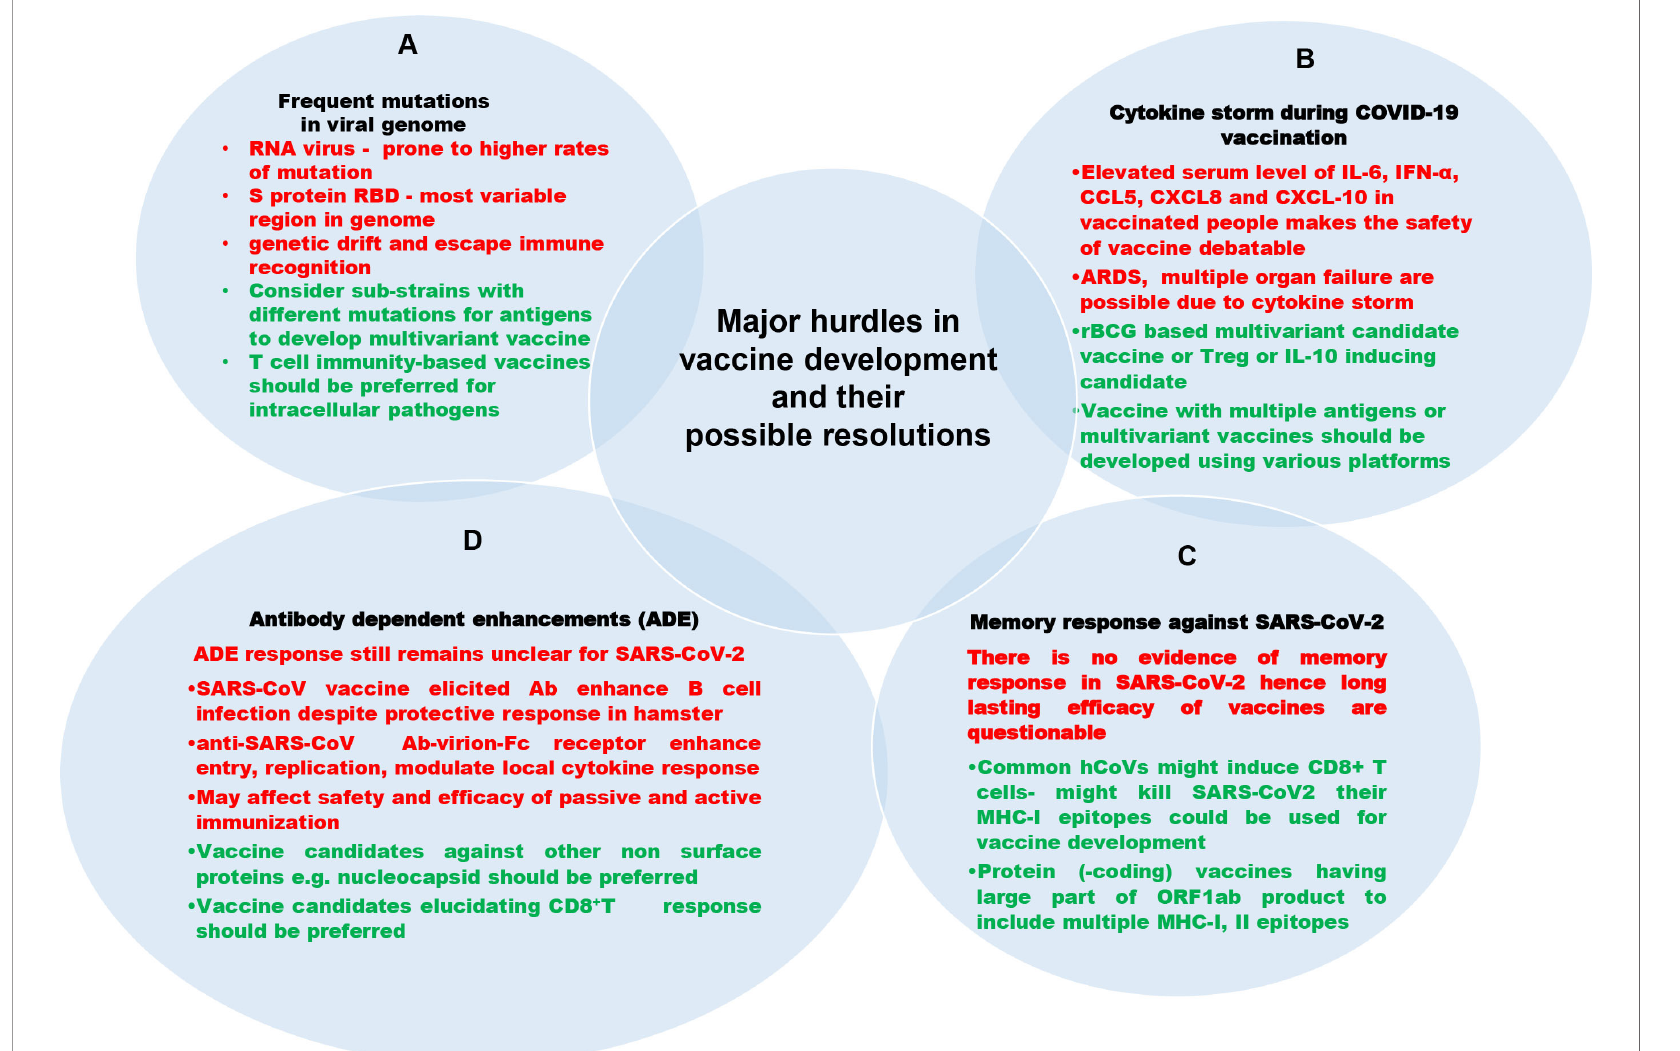
FIGURE 6 | Challenges in developing vaccines against SARS-CoV-2 (black color text), their description (red color text) and their possible resolutions (green color text). (A) Mutation in viral genome: The RNA viruses including SARS-CoV-2 are more prone to mutation in their genome, leading to viral immune evasion. (B) Cytokine storm during COVID-19 vaccination: Occasionally, the vaccination may lead to cytokine storm and other complications raised by it. (C) Lack of memory response: Any vaccine provides long-lasting ef fi cacy only because of memory responses of adaptive immunity. No vaccine against SARS-CoV-2 is documented to have established memory response postvaccination. The neutralizing antibody fades away a few months post vaccination. (D) Antibody-dependent enhancements: There is the possibility of an antibody-mediated increase in infection called antibody dependent